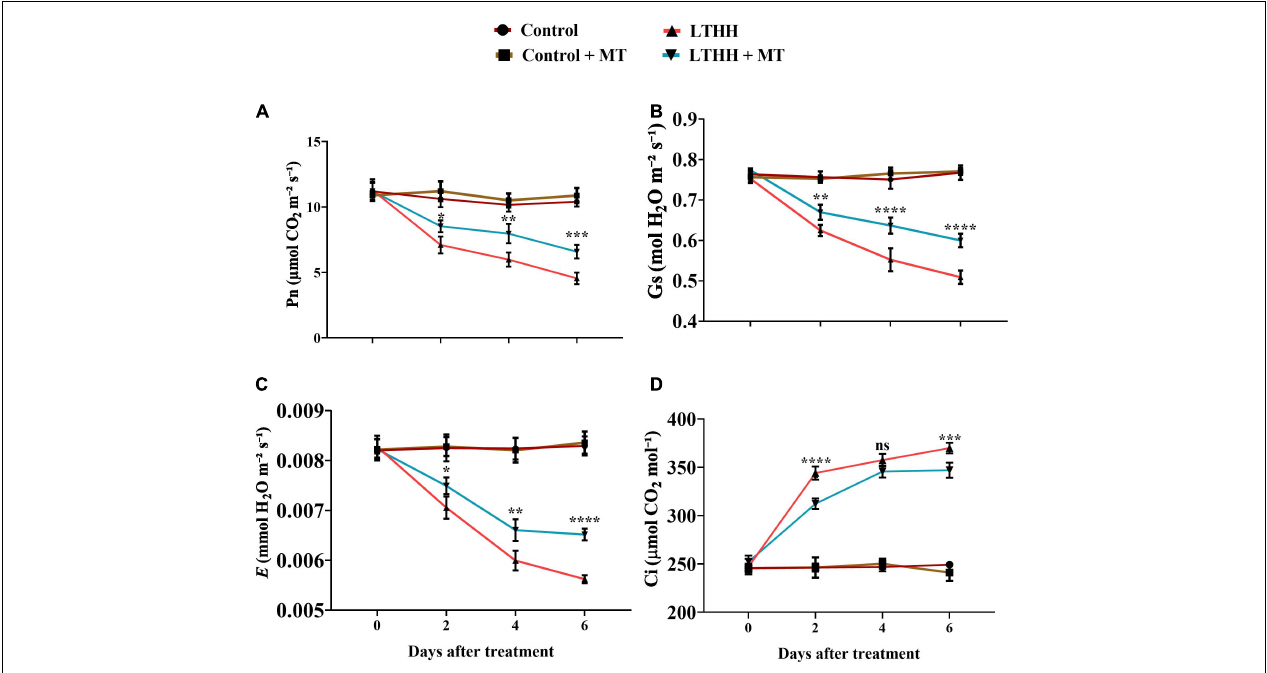
FIGURE 1 | Effect of exogenous melatonin on net photosynthesis (A) , stomatal conductance (B) , transpiration rate (C) , and intercellular concentration of carbon dioxide rate (D) of cucumber seedling under low-temperature and high-humidity stress. Control (25/18 ◦ C); Control + MT (200 µ M melatonin, 25/18 ◦ C);